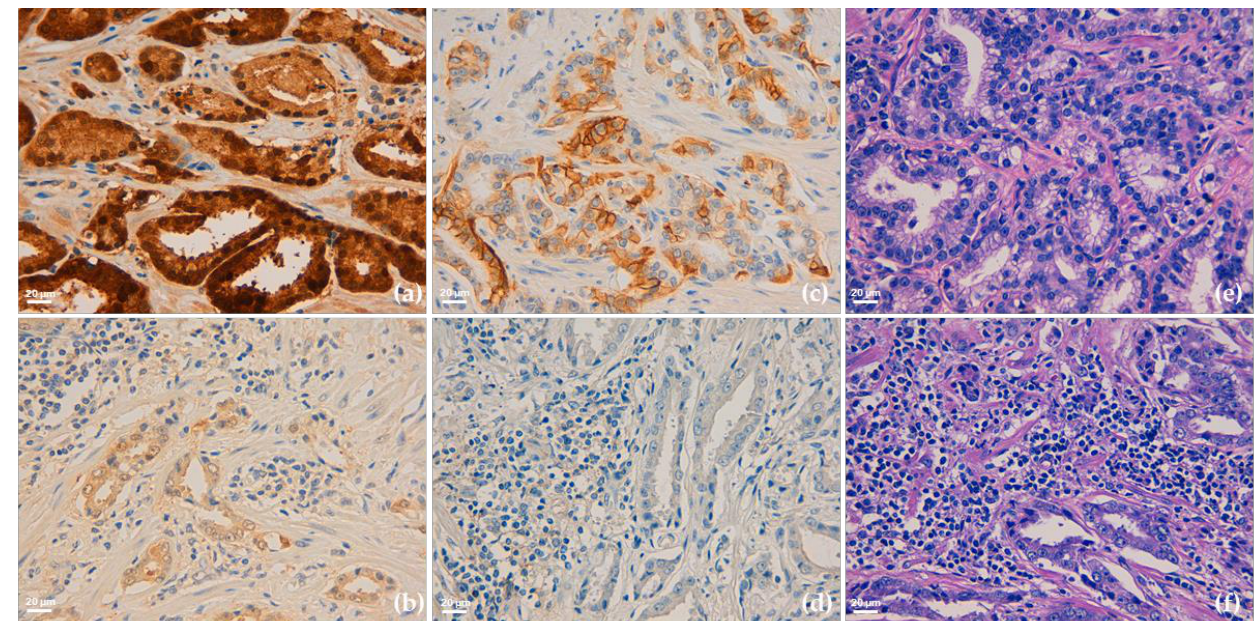
Figure 1. Representative immunohistochemical staining of Glyoxalase 1 (Glo1) ( a , b ), PD-L1 ( c , d ) expression and tumor infiltrating lymphocytes (TILs) asset ( e , f ) in human prostate cancer tissues. Images ( a , c , e ) refers to the same patient and are characterized by a parallel high expression of both Glo1 ( a ) and PD-L1 ( c ), and an almost absence of stromal TILs. As controls, images ( b , d , f ) refers to another patient and are characterized by a parallel low expression of both Glo1 ( b ) and PD-L1 ( d ) and a diffuse presence of grade 3 TILs; ( e , f ) hematoxylin and eosin staining. Original magnification: 400 × . The scale bar indicates 20 µm.